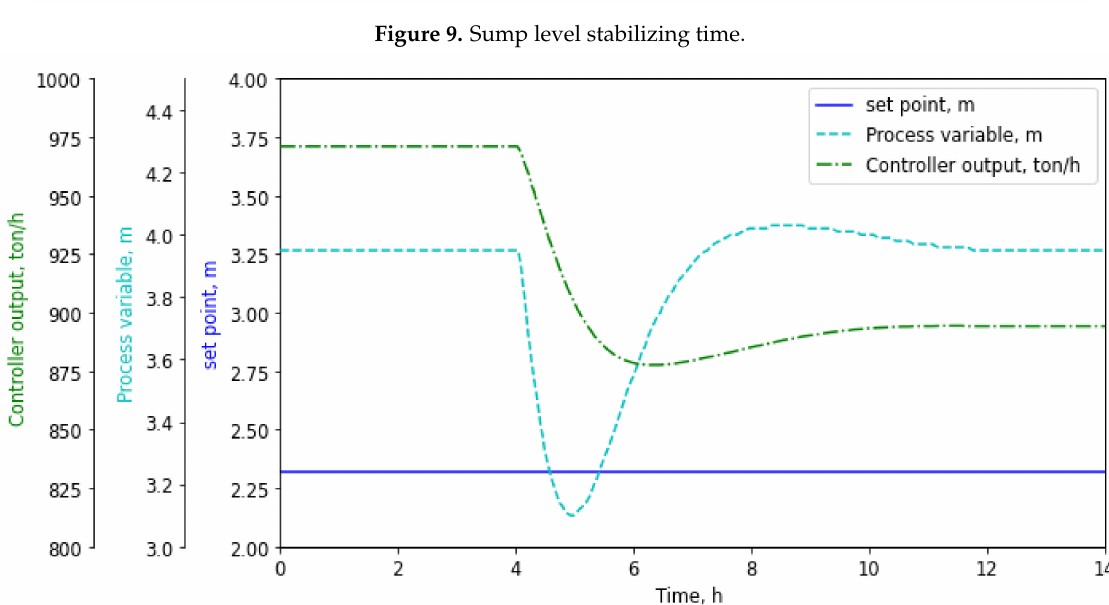
Figure 10. Stripper sump stabilizing